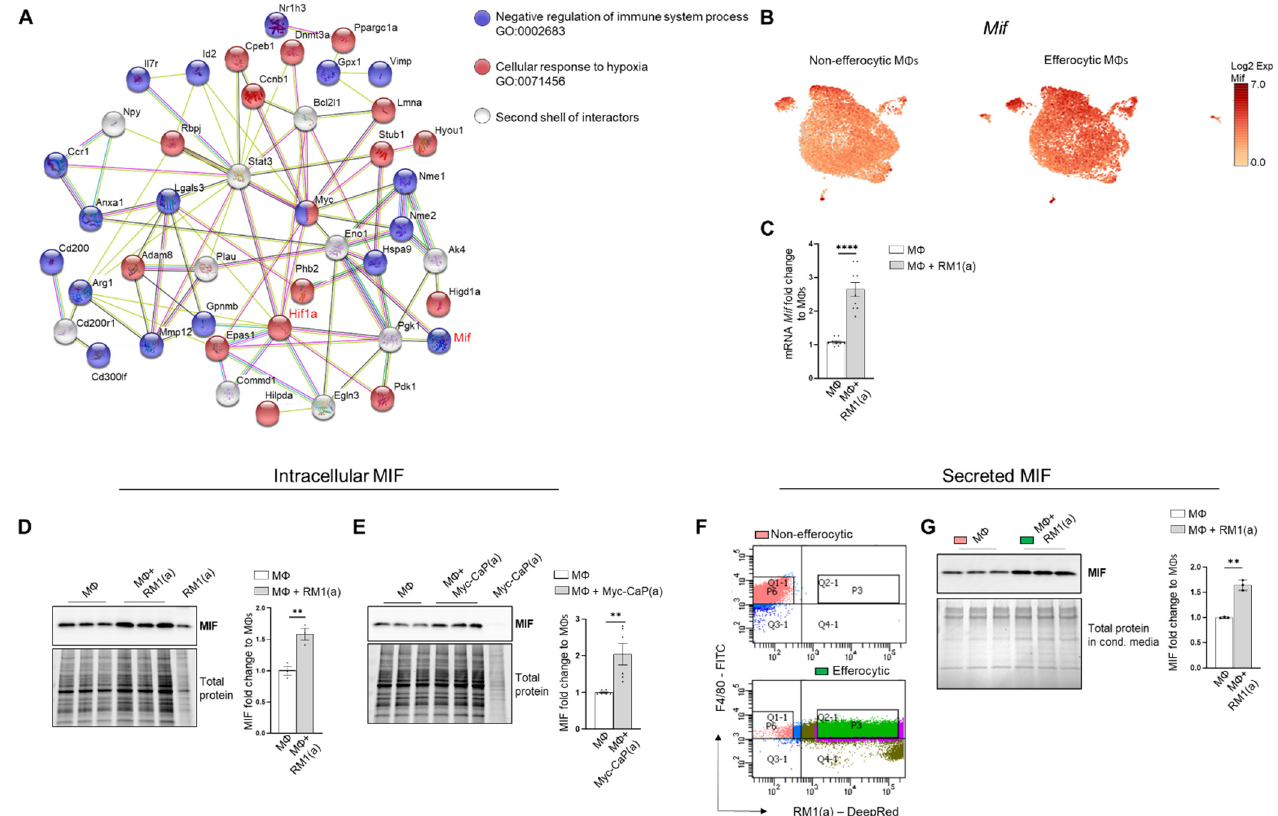
Figure 3. BM macrophage efferocytosis induces MIF expression. ( A ) Protein–protein interaction network between the immune pathway regulation and the hypoxia-related pathway. Biological Process GO terms of selected genes upregulated by efferocytosis (GO:0002683, all genes; GO:0071456, 25 out of 33 genes). BM macrophages (M Φ ) were isolated from 4 wk old C57BL/6J or FVB/NJ mice and co-cultured with apoptotic RM1(a) or Myc-CaP(a) cells for 16–18 h. ( B ) scRNA-Seq analysis plot shows Mif distribution in efferocytic and non-efferocytic clusters of BM macrophages. ( C ) Mif mRNA expression in efferocytic BM macrophages assessed by RT-qPCR ( n = 9). Western blot analysis of protein lysates from ( D ) C57BL/6J BM macrophages co-cultured with apoptotic RM1 prostate cancer cells ( n = 3) and ( E ) FVB/NJ efferocytic and control BM macrophages were analyzed by Western blotting using MIF antibody ( n = 6). ( F ) C57BL/6J efferocytic (F4/80 + DeepRed + (in green)) and control non-efferocytic BM macrophages (F4/80 + (in salmon)) were sorted, seeded, and incubated for 6 h. ( G ) Western blot analysis of conditioned media from non-efferocytic and efferocytic BM macrophages ( n = 3/group). The Western blot shown in E is a representative image. Plotted data are shown as mean ± SEM of quantified signal after normalization to total protein and to control BM macrophages, ** p < 0.01, **** p < 0.0001 (unpaired t -test). Additional results are shown in Appendix A— Figure A5.